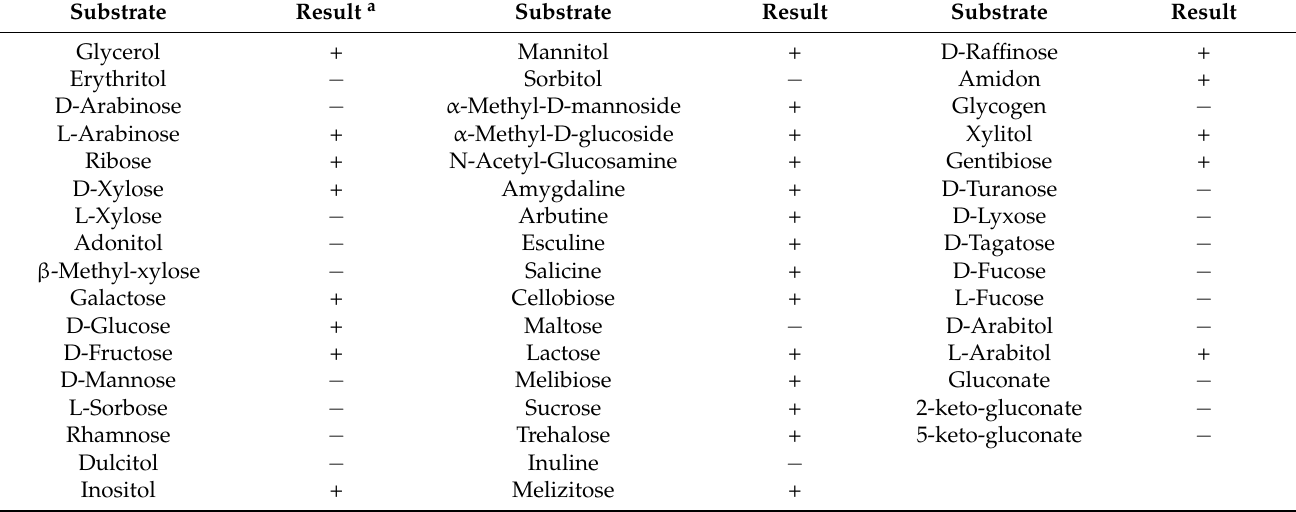
Table 9. Carbohydrate fermentation activities of B . subtilis